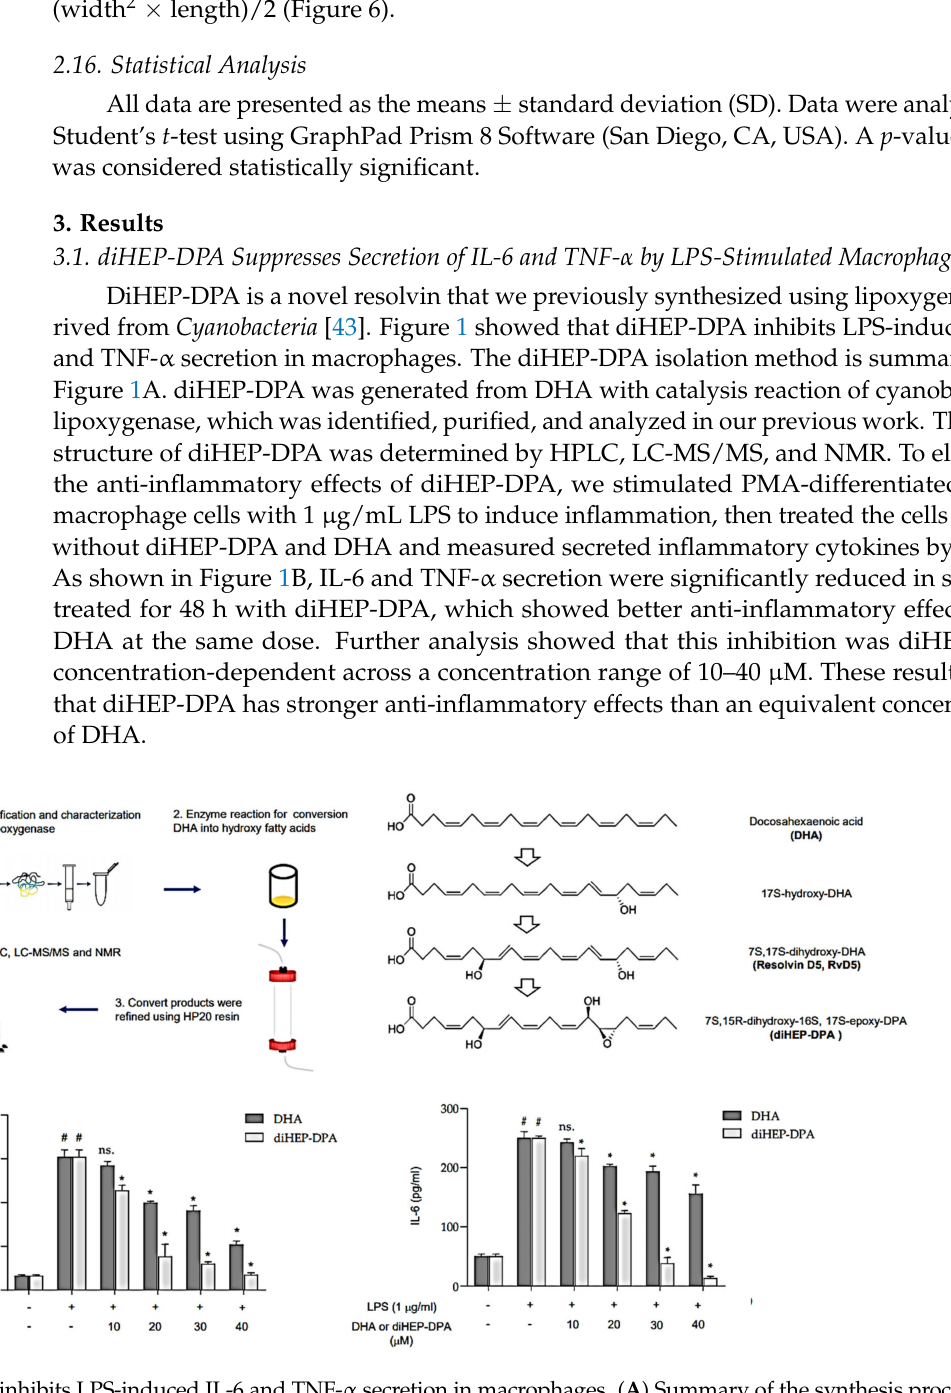
Figure 1. DiHEP-DPA inhibits LPS-induced IL-6 and TNF- α secretion in macrophages. ( A ) Summary of the synthesis process of diHEP-DPA. ( B ) Production of IL-6 and TNF- α by LPS-stimulated (inflamed) macrophages was inhibited by different concentrations of diHEP-DPA and DHA. Cytokines were measured by ELISA. Data from triplicate experiments are presented as the means ± SD ( # p < 0.05 versus the DMSO-treated control group; * p < 0.05 versus the LPS-treated positive control